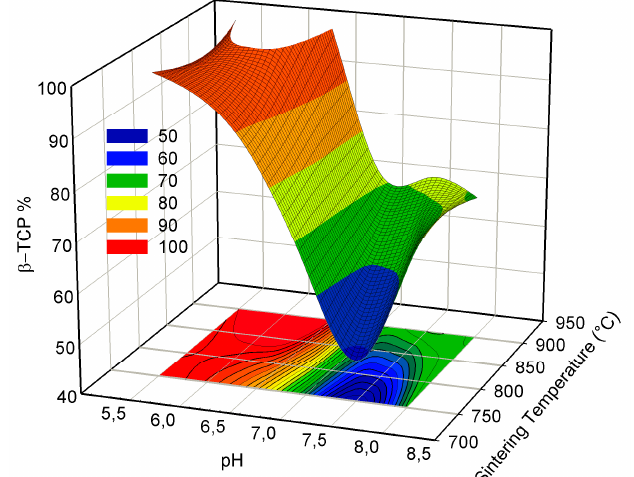
Figure 5. The percentage of transformation depending on the reaction pH and sintering temperature. Among all the synthesis and sintering conditions, a complete transformation of CDHA to β -TCP was only observed for the pH 5.5/750 °C and pH 5.5–6.5/900 °C samples.